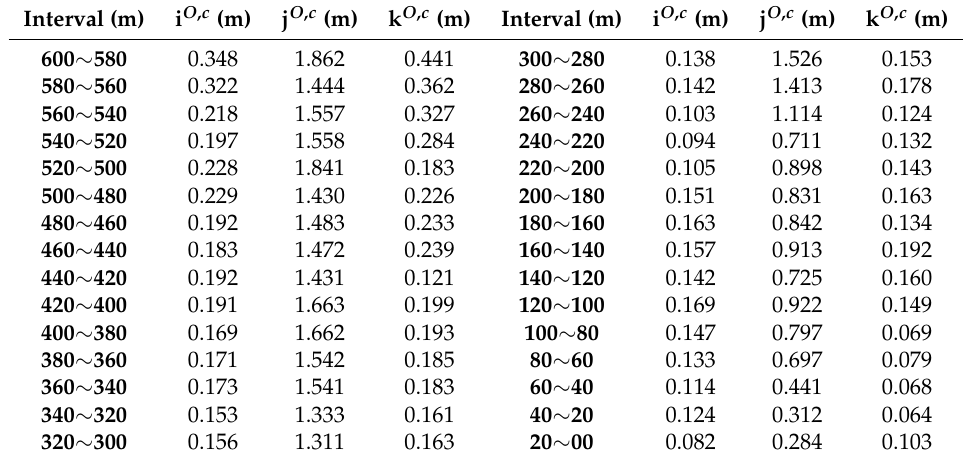
Table 5. Localization error in each axis at separated intervals with the DSST and bounding box prediction (BBP) algorithms.